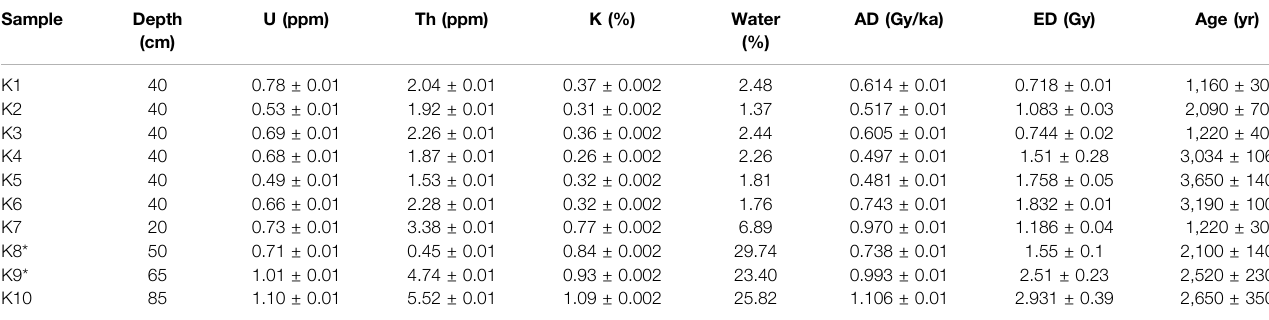
TABLE 1 | Results of OSL dating from inner, outer beach ridges and trench.